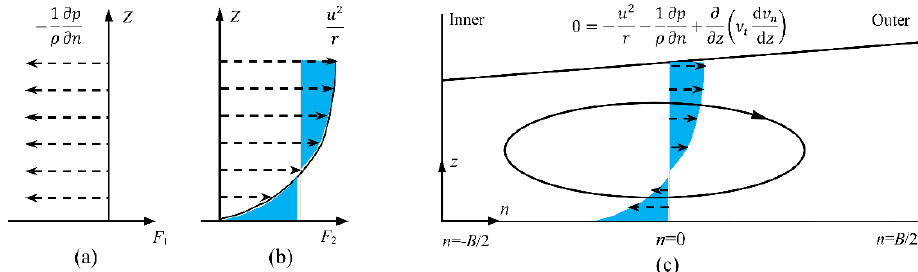
Figure 9. Schematic representation of curvature-induced secondary flow in a cross-section of a curved river reach; F1 represents the inward pressure difference; F2 represents the outward centrifugal force.